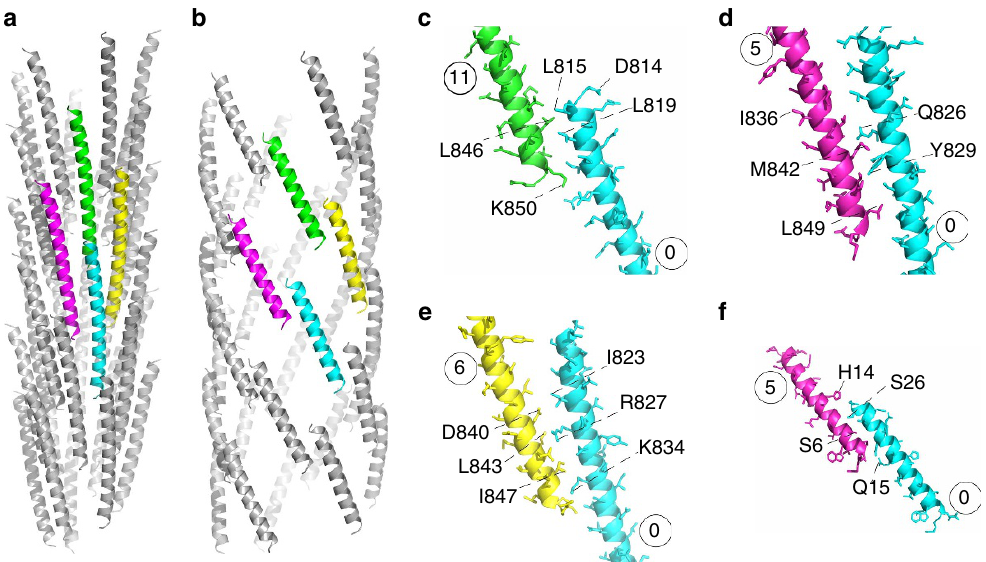
Figure 3 | D0 interactions in the hook. Inter-molecular interations between FlgE proteins in the central core between the C-terminal ( a ) and between the N-terminal ( b ) a -helices of domain D0 taken from 33 molecules. The coloured helices highlight these interactions in the 11-start ( c ), in the 5-start ( d ) and in the 6-start ( e ) direction for the C-terminal a -helices. The N-terminal a -helices only interact in the 5-start direction ( f ). The numbers indicate the order of appearance of each FlgE molecule during the building of the hook. Figure prepared with PyMOL.